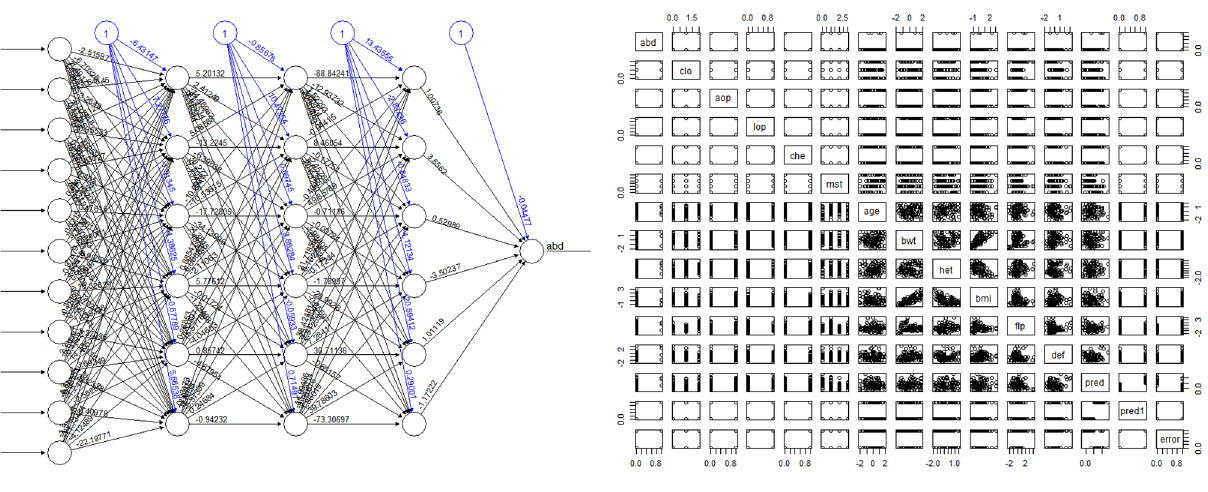
Figure 3. Plot diagram of highest predictive neuralnet function (left) and the result (right). There were six hidden neurons each involved in three hidden layers, resilient backpropagation with backtracking algorithm, sum of squared errors for error calculation, and logistic function for smoothing the result. Maximum steps were set at 10 6 . R program version 3.6.3 (The R Foundation for Statistical Computing, Vienna, Austria) was used in creating